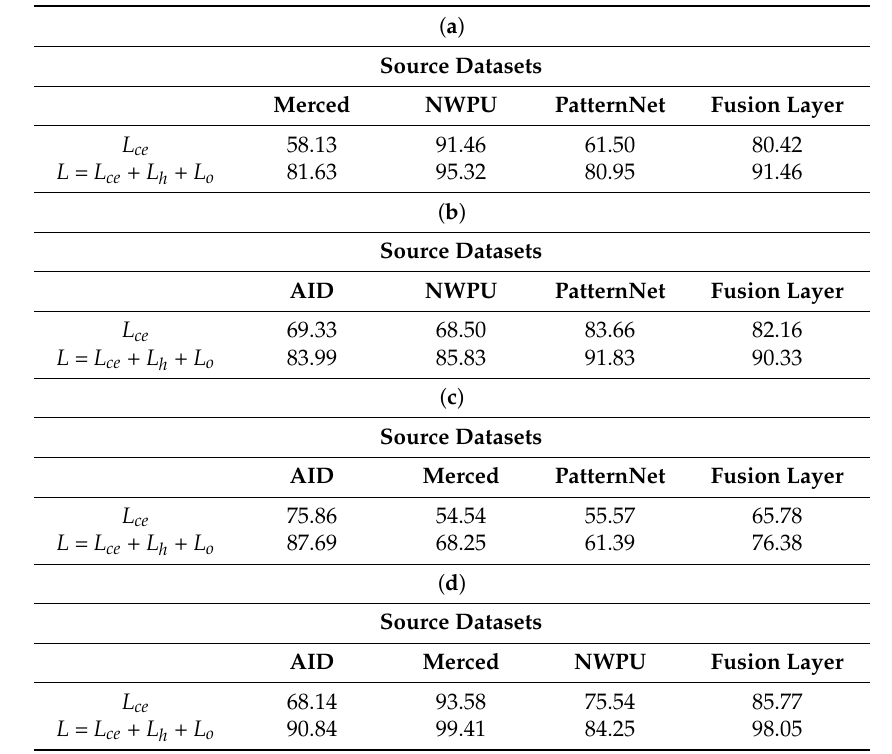
Table 2. Results in terms of overall accuracy (OA) (%) obtained by MB-Net, trained by optimizing the cross-entropy loss L ce and the total loss L : ( a ) AID, ( b ) Merced, ( c ) NWPU and ( d )